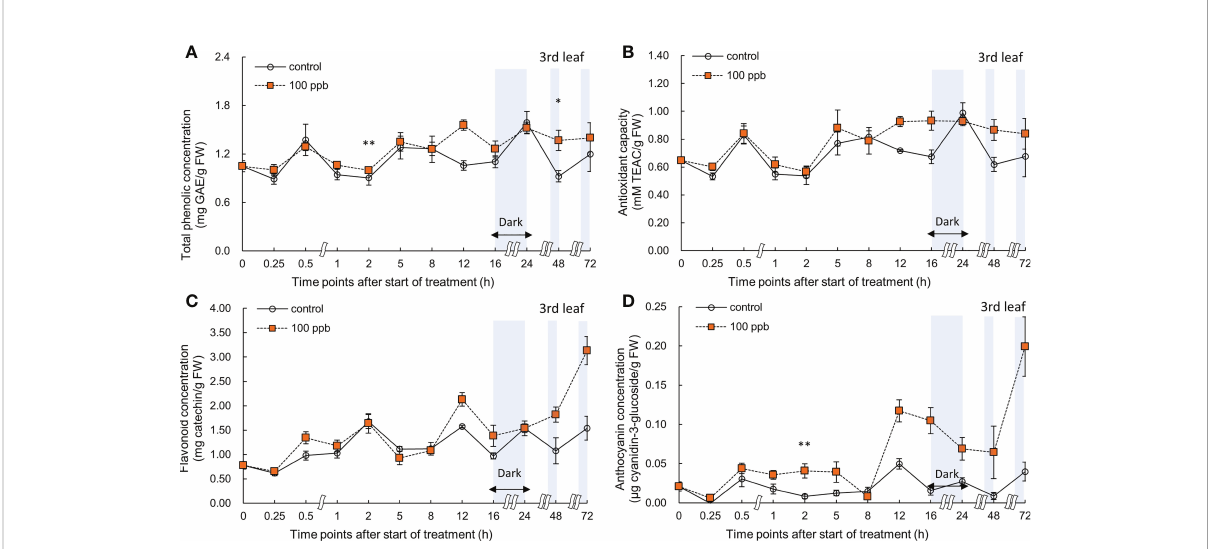
FIGURE 6 Total phenolic concentration (A) , antioxidant capacity (B) , total fl avonoid concentration (C) , and anthocyanin concentration (D) of third red leaf lettuce subjected to 100 − ppb ozone treatment for 72 h. The vertical vars indicate SE (n=4). Statistically signi fi cant differences are indicated at * p < 0.05 and ** p < 0.01 by T-test.